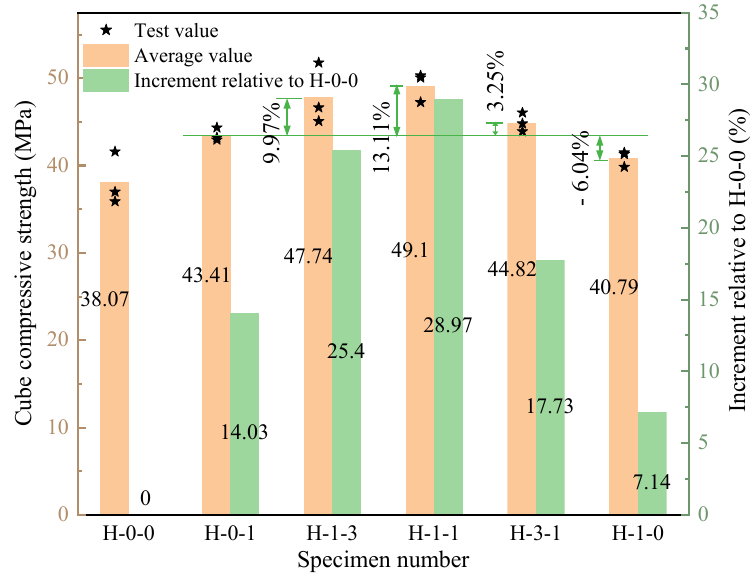
Figure 6. Compressive strength of LHPCC with different fiber hybrid proportions.